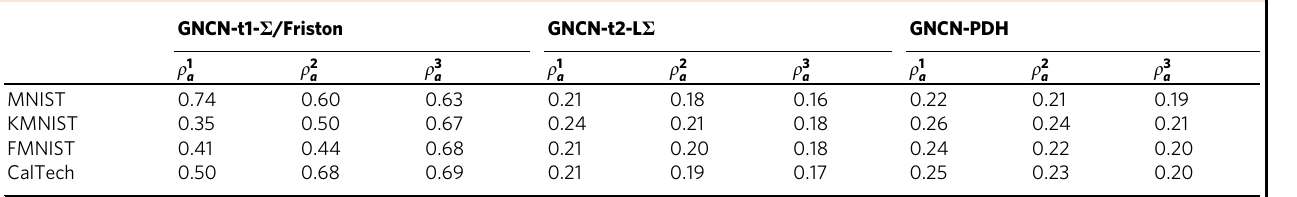
Table 3 Latent sparsity